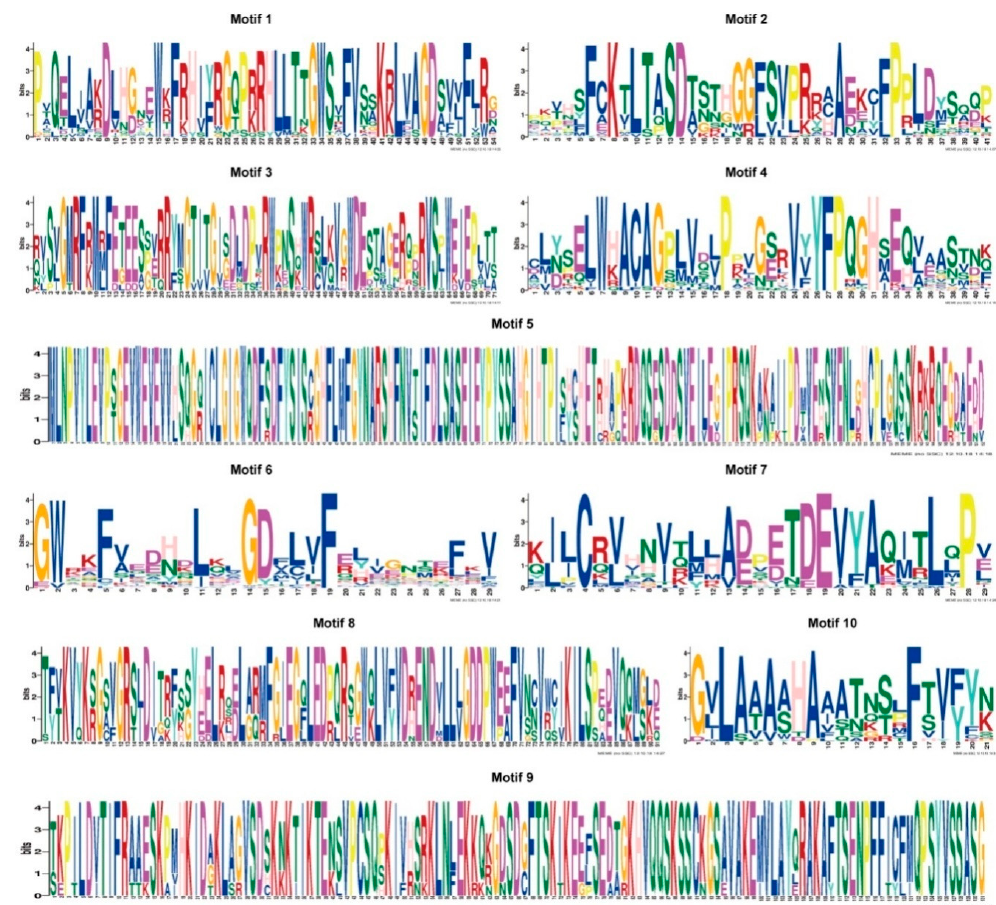
Figure 5. Sequence logos of the ten conserved motifs identified using MEME tools from the B3 proteins in tobacco. Total height of the residues stack indicates the information content of that position in the motif. Height of residues within the stack indicates the probability of each residue at that position.